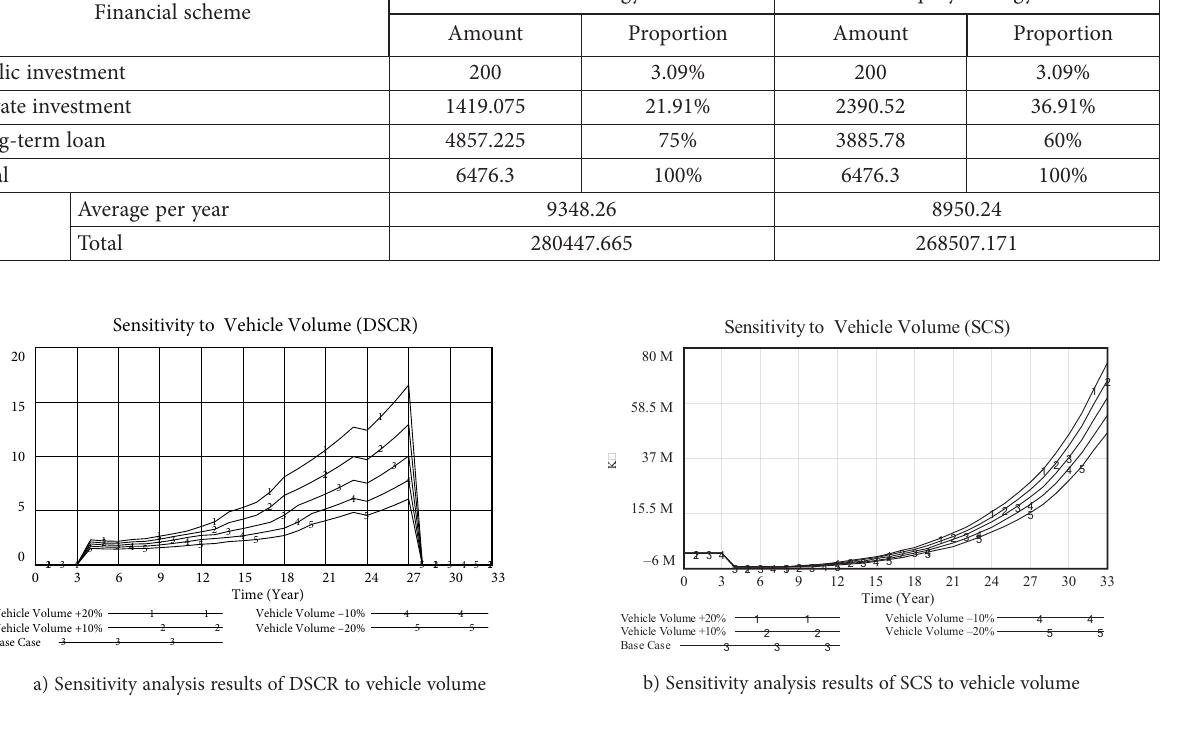
Financial scheme